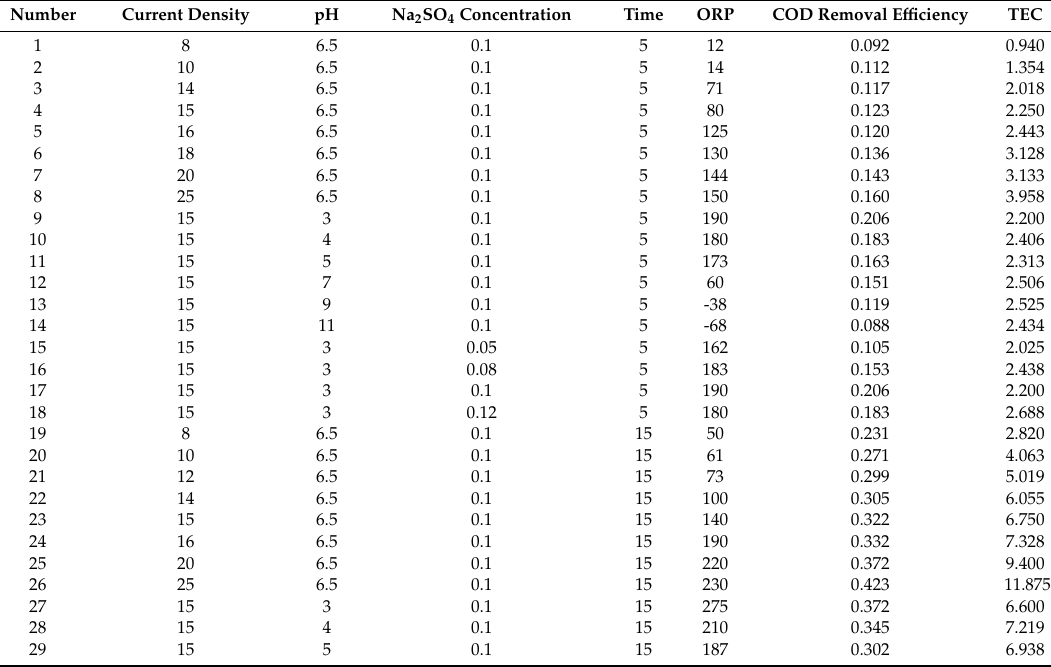
Table A1. The results of the electro-oxidation